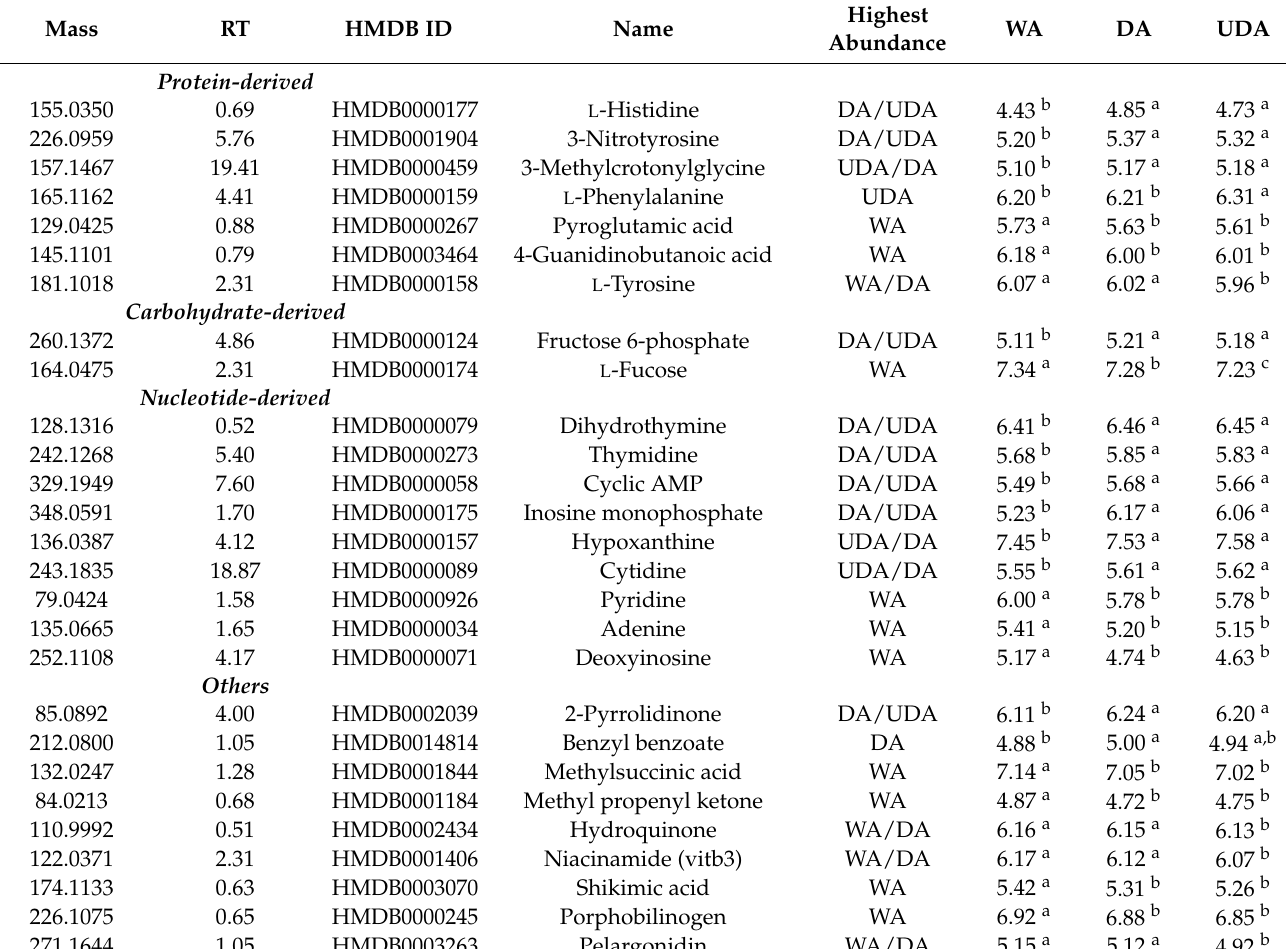
Table 6. Effect of different aging treatments on metabolomics profile of pork loins ( M . Longissimus lumborum ) aged for 21 days ( p -value < 0.05 and FDR <